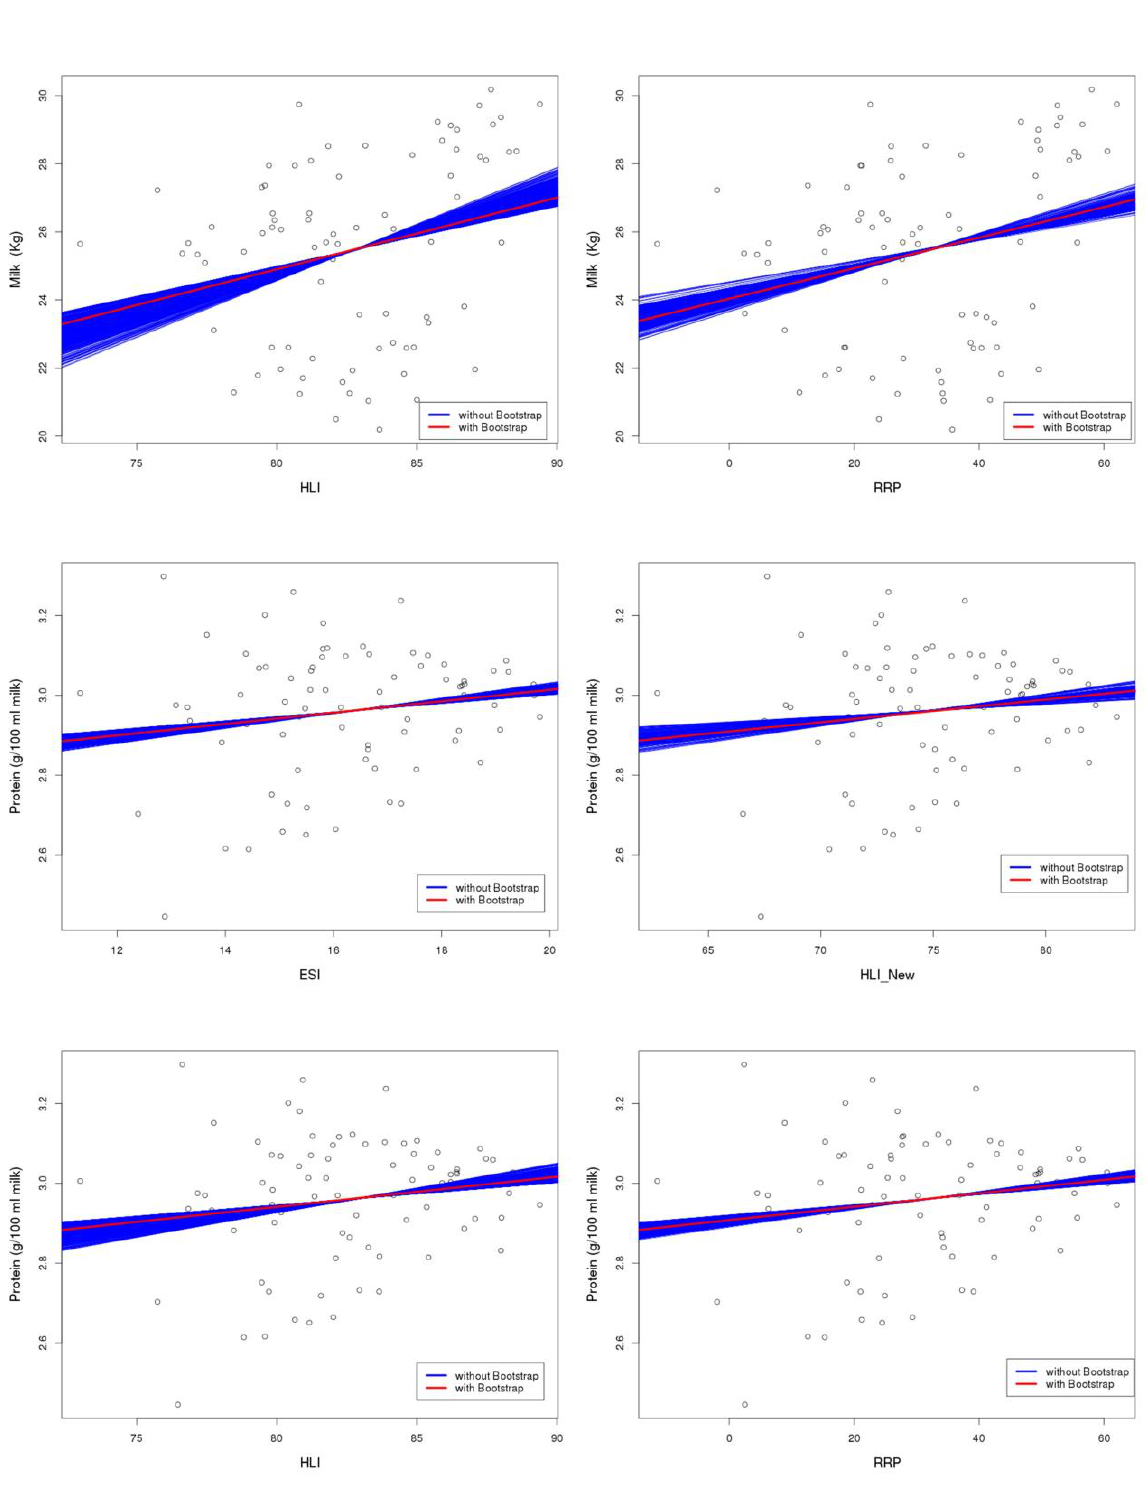
Figure A2. The best-fitted regression line before (red line) and after bootstrapping (N = 1000) (blue lines) between indices (ESI, HLI, HLI New , and RRP) and milk components (fat, protein and milk yield) in the